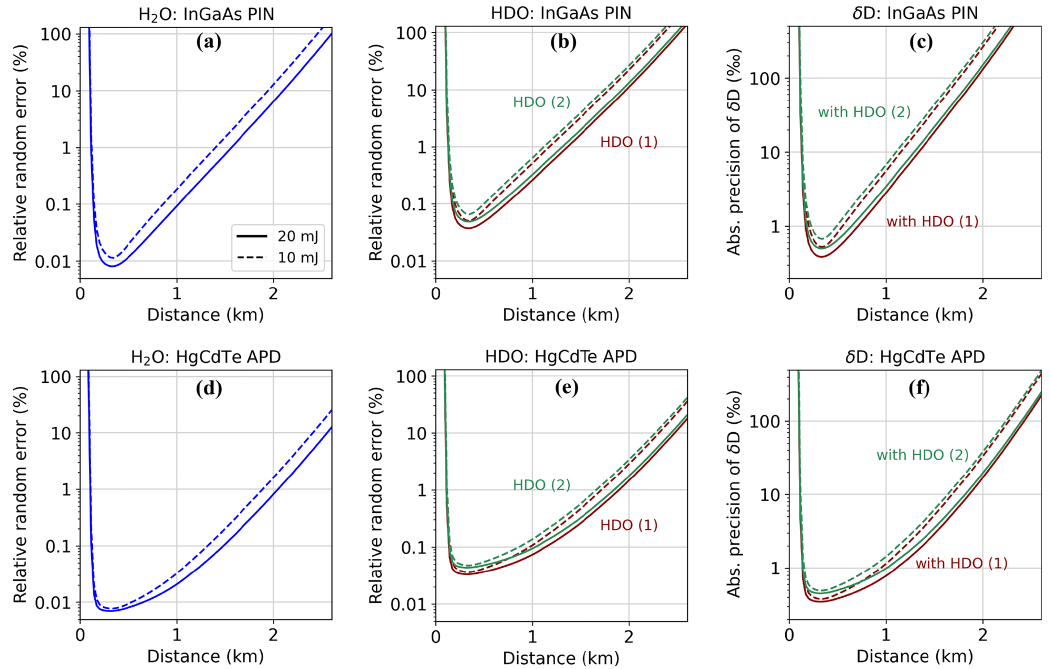
Figure 5. Expected relative random error in the volume mixing ratio of H 2 O and HDO for different pulse energies (solid lines: 20mJ; dashed lines: 10mJ) and detectors: (a–b) InGaAs PIN detector, (d–e) HgCdTe APD. (c, f) Corresponding absolute uncertainty (standard deviation) in δD as a function of distance from the lidar instrument. A detection bandwidth of 1MHz is assumed, and signal averaging time is